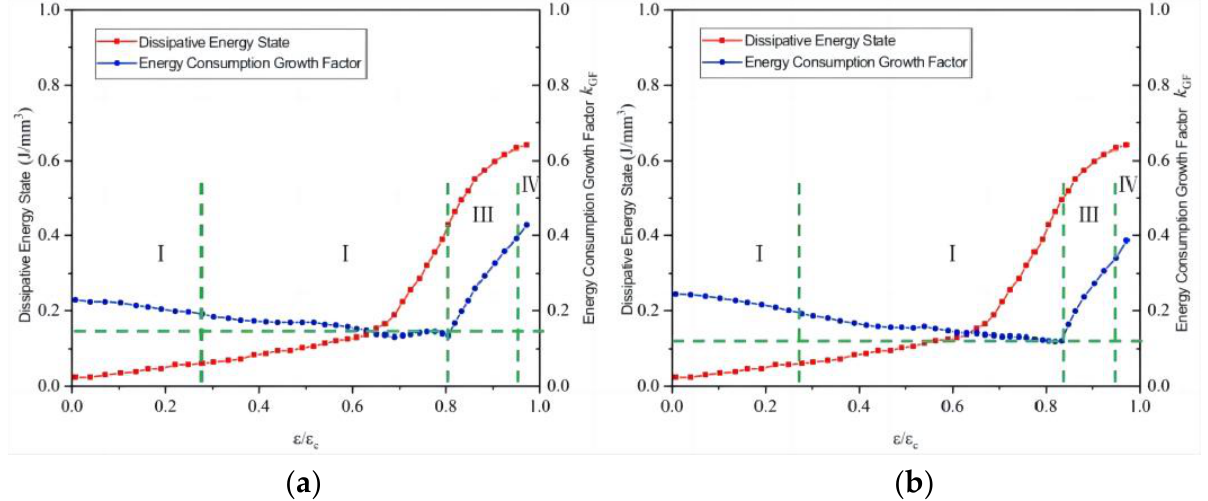
Figure 14. Energy consumption growth factor evolution diagram of coal specimen failure process. The green line is used to delineate the different stages through which the coal samples in the diagram have gone. ( a ) Dissipative energy stage and k GF of the coal sample S1. ( b ) Dissipative energy stage and k GF of the coal sample S2.